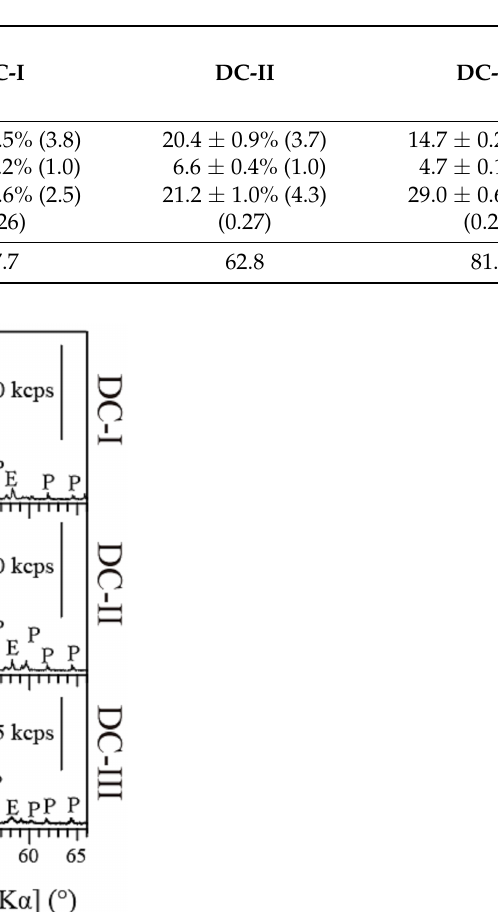
Table 1. The elemental composition (based on the total acid digestion analysis) and particle size of each concentrate used in this study.